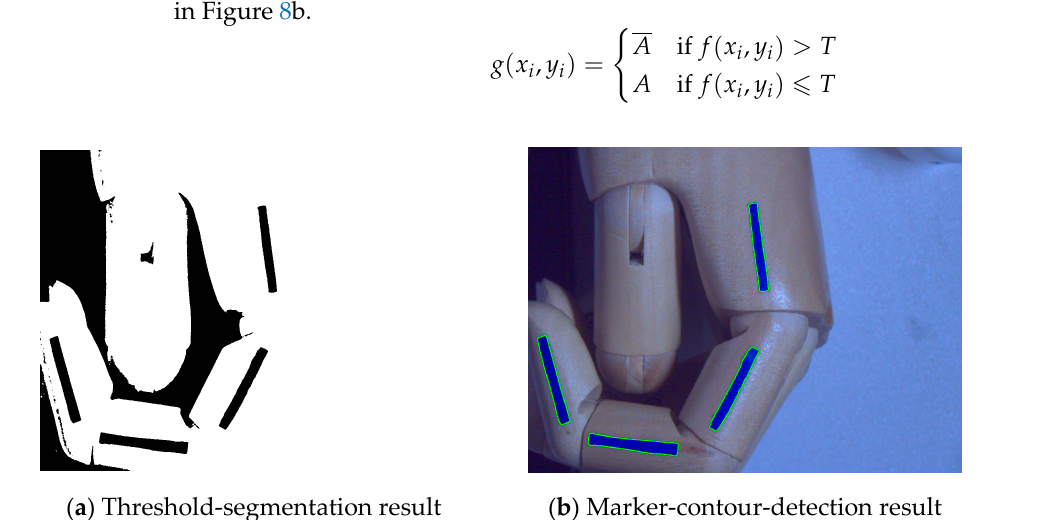
Figure 8. Image-thresholding segmentation and contour-detection results.